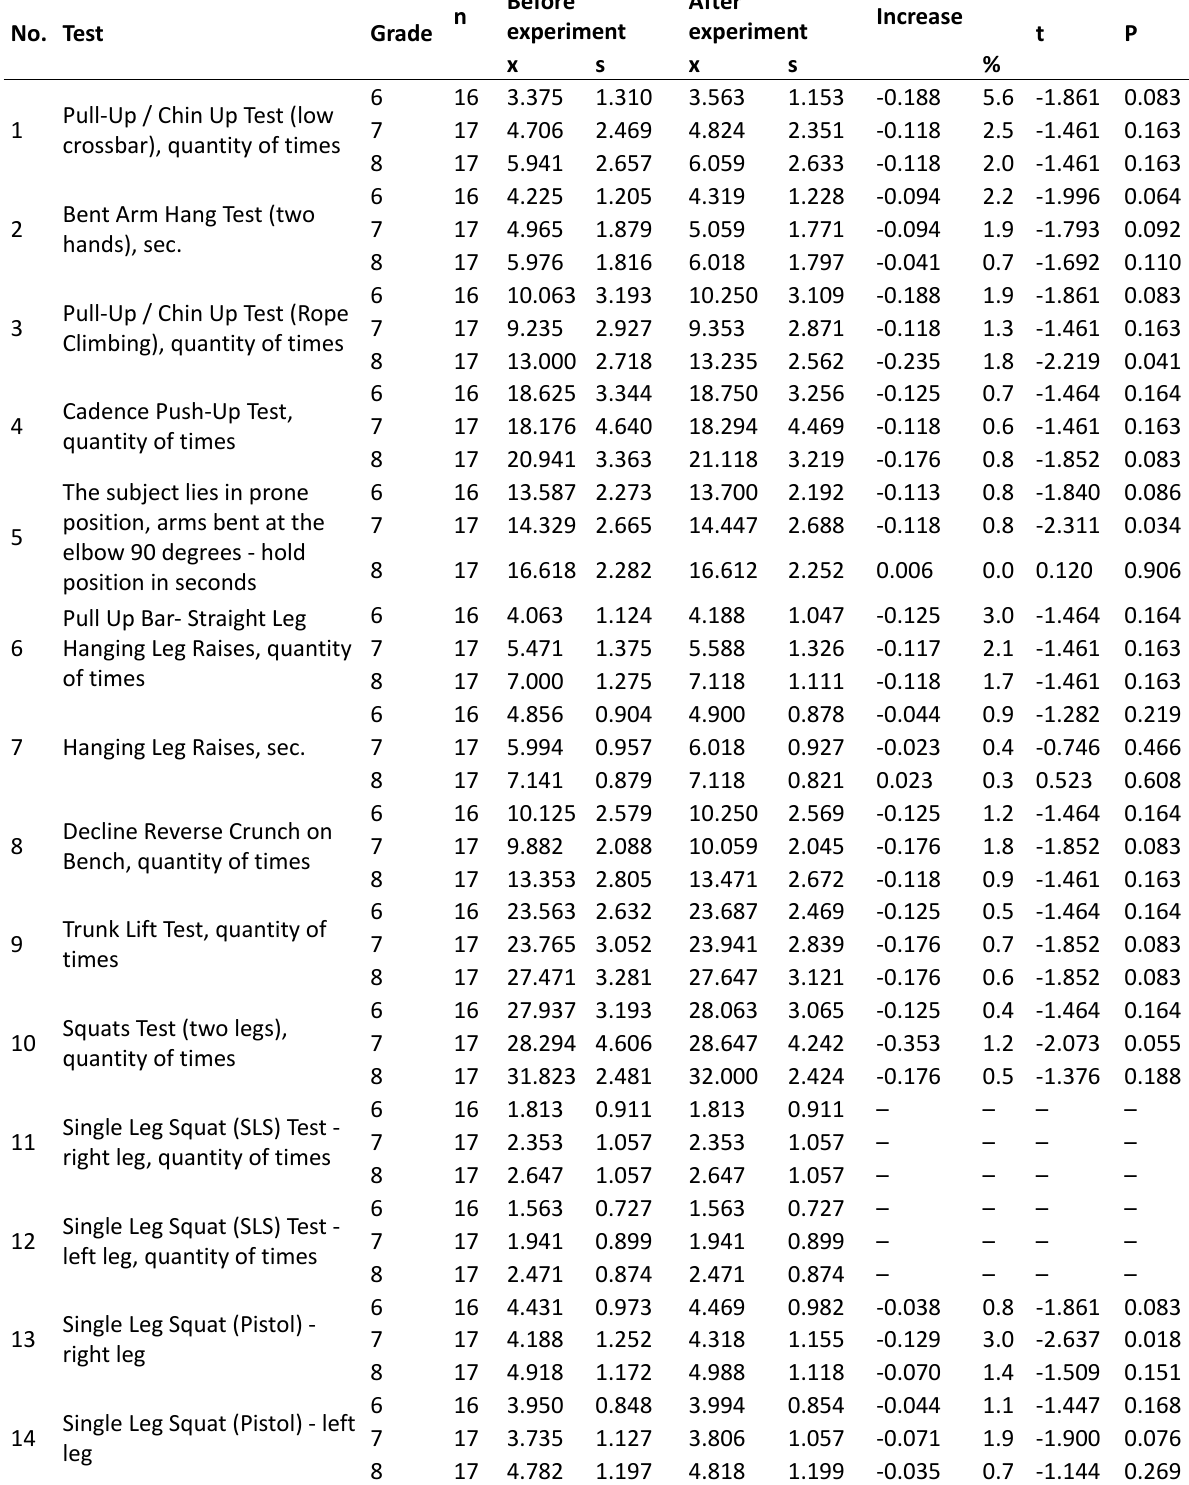
Table 3. Test results of strength fitness of 6 th -8 th grade boys (control group). Circuit training method